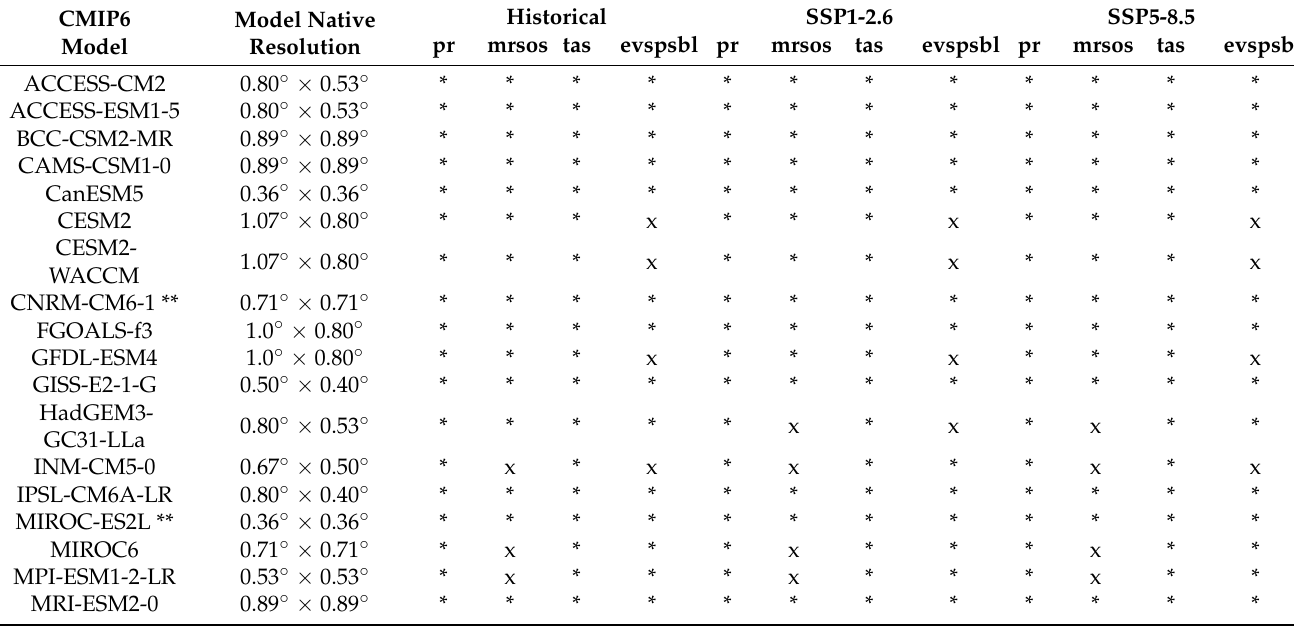
Table 1. Models used from the 6th Phase of the Coupled Model Intercomparison Project (CMIP6). CMIP6 Model Native Model Resolution ACCESS-CM2 BCC-CSM2-MR CanESM5 CESM2- WACCM CNRM-CM6-1 ** FGOALS-f3